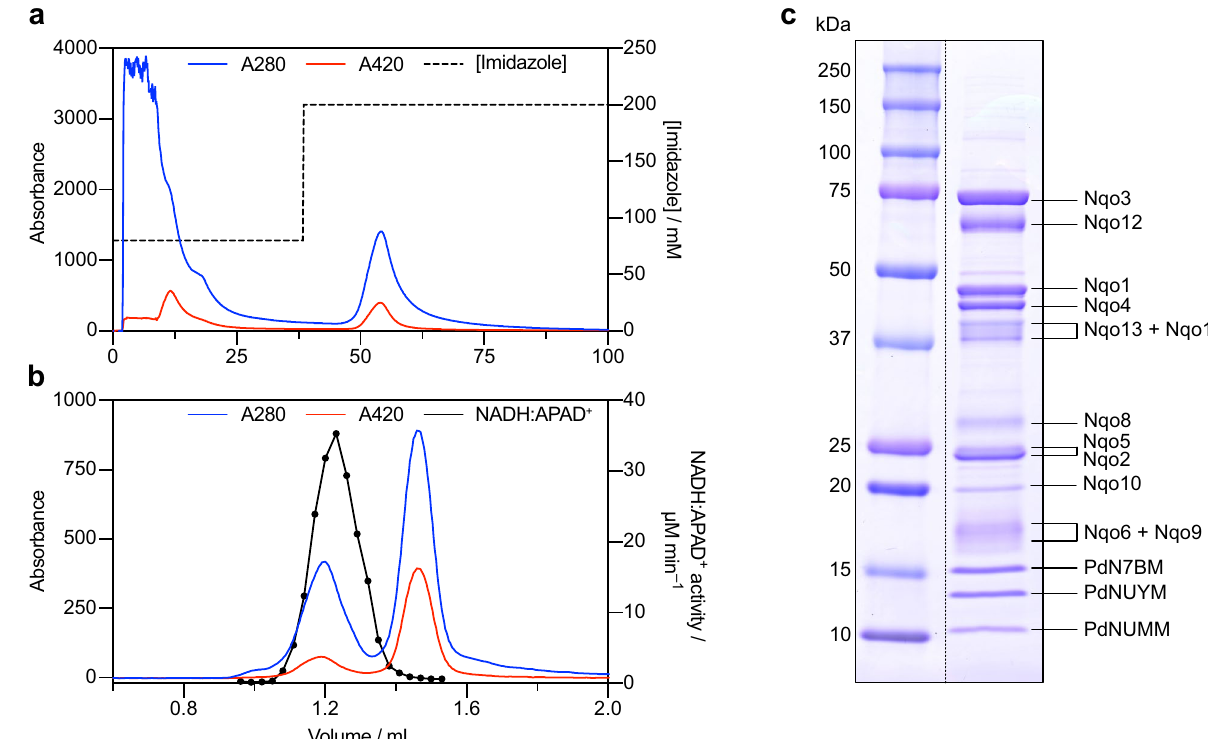
Figure 1. Purification and subunit composition of P. denitrificans complex I. ( a ) Typical Ni-affinity chromatography trace produced using a HisTrap HP column. The column was washed with 80 mM imidazole and protein eluted with 200 mM imidazole. ( b ) Typical size exclusion chromatography trace using a Superdex 200 increase 5/150 GL column. Complex I was identified by measuring the relative NADH:APAD + activity in eluted fractions (black trace). ( c ) SDS-PAGE analysis of purified P. denitrificans complex I. Two full-length lanes are shown from a single gel; the image has been cut and they have been moved to be adjacent to each other. The original image is shown in SI Fig. S6. Individual complex I subunits were identified and assigned by excising each band, treating the sample with trypsin and analyzing the resultant peptides by mass spectrometry. Peptides were assigned to a subunit/protein by peptide mass